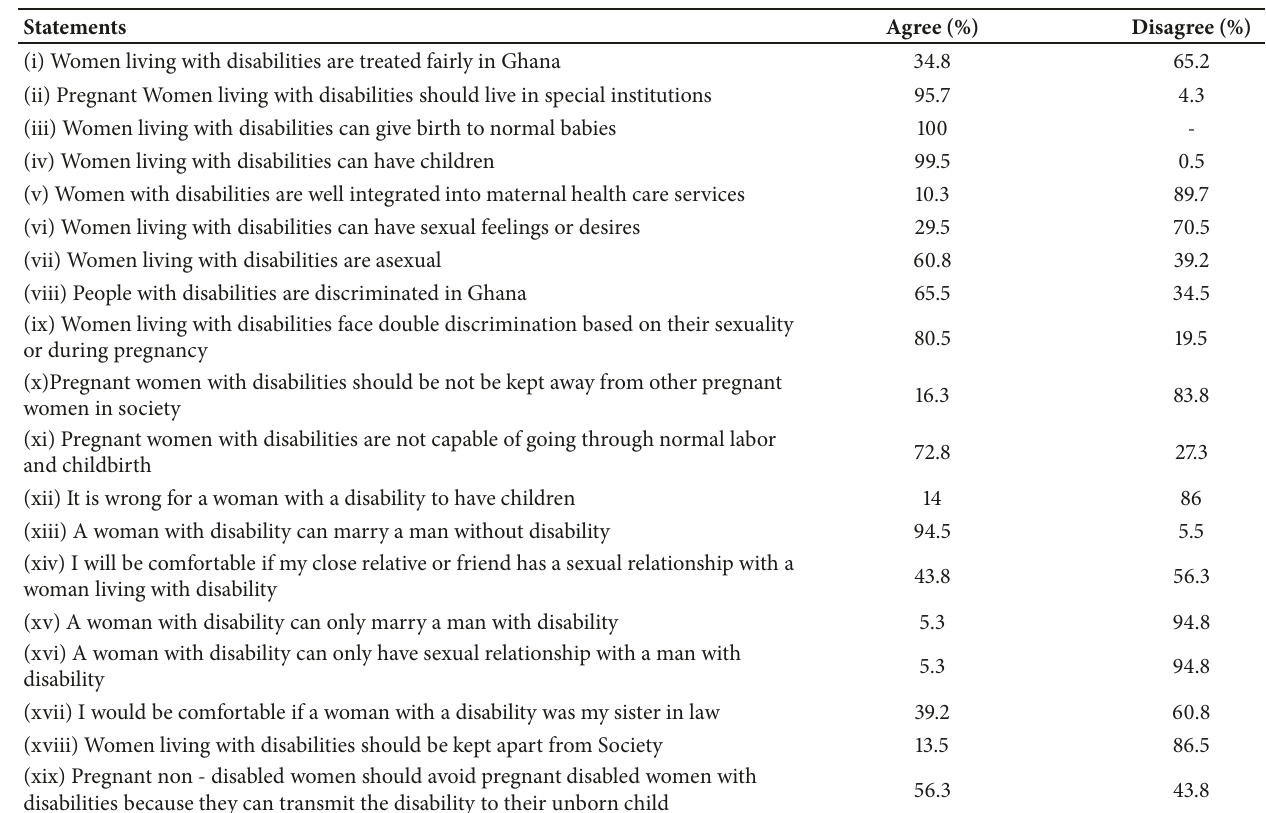
Table 4: Respondents’ perceptions about sexuality and pregnancy of female